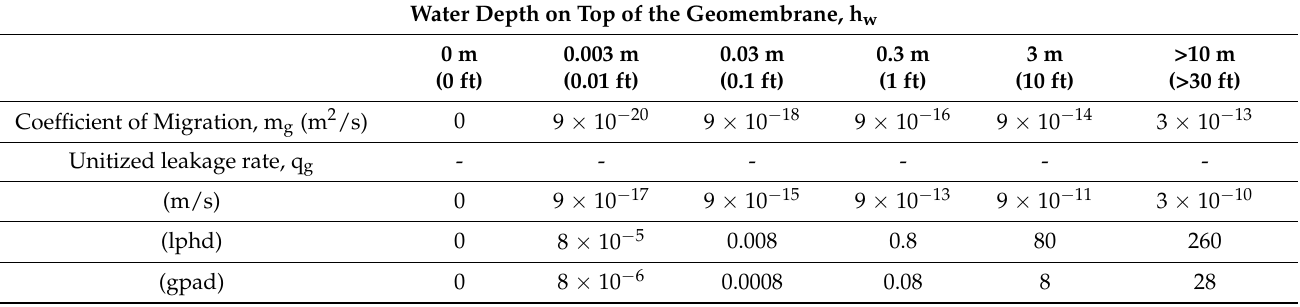
Table 5. Calculated unitized leakage rates, 1 L per hectare per day (lphd), due to permeation of water through an HDPE geomembrane (1 mm) [39,40]. Water Depth on Top of the Geomembrane, h w